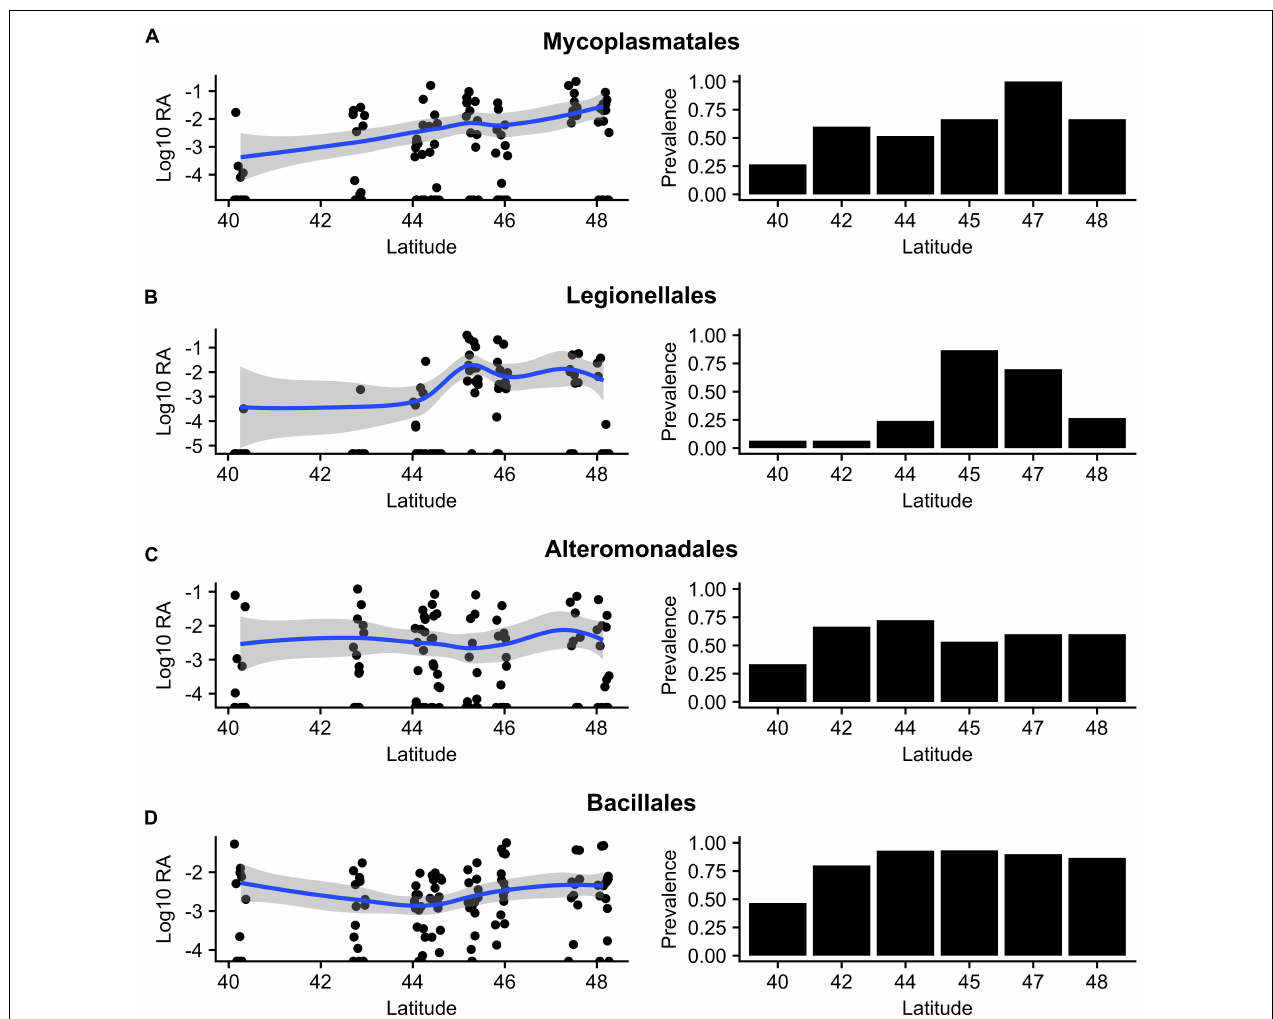
FIGURE 8 | Log10 relative abundances (left) and prevalence (right) of the four most abundant core orders (prevalence > 50%) reveal trends in abundance and presence/absence across eight degrees of latitude: (A) Mycoplasmatales, (B) Legionellales, (C) Alteromonadales, and (D)